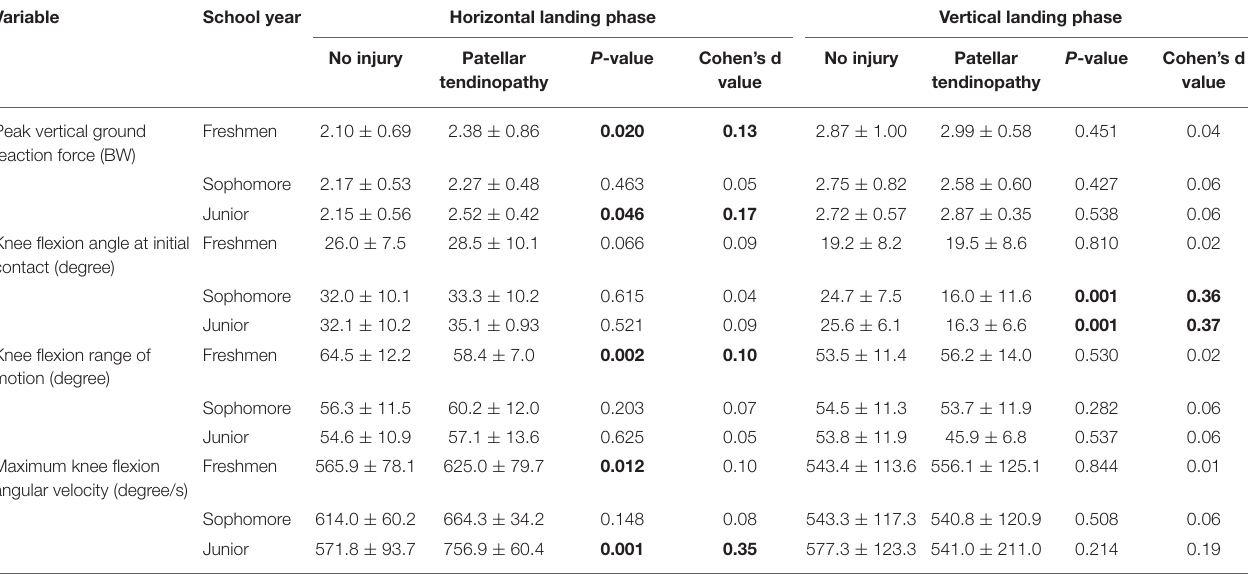
TABLE 3 | Comparisons between no injury and patellar tendinopathy groups in male players ( P -value ≤ 0.05 was considered as statistical significance. A difference was considered as large if Cohen’s d value ≥ 0.05, as medium if 0.05 < Cohen’s d value ≤ 0.02, and as small if Cohen’s d value <